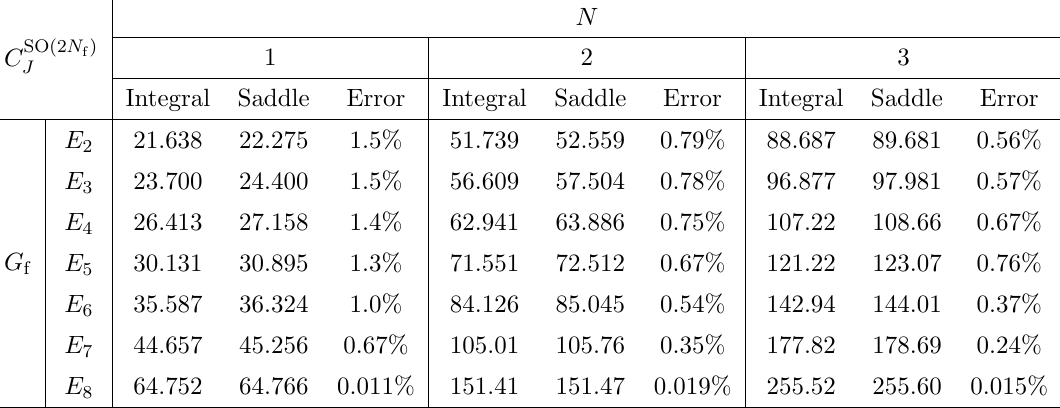
in the rank-one to rank-three J